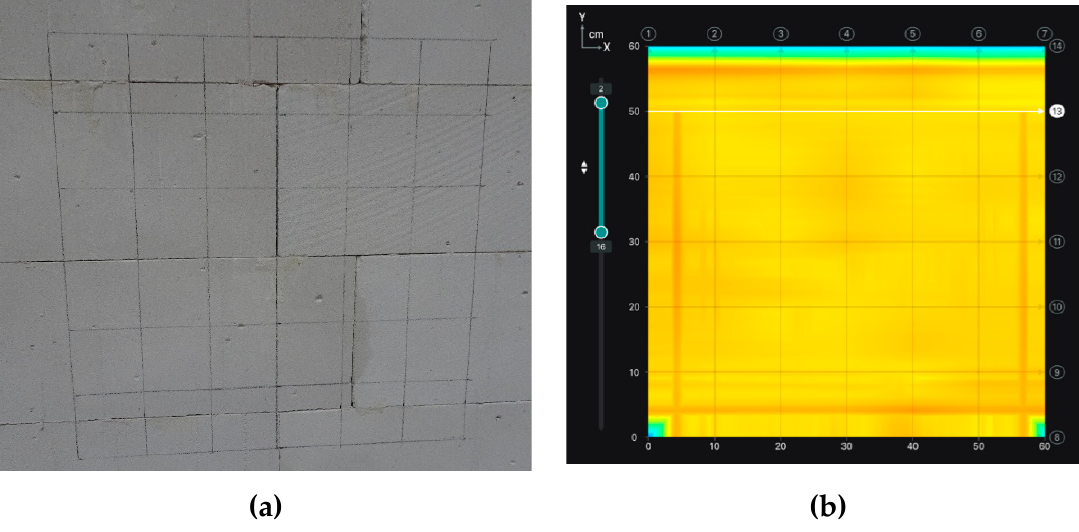
Figure 6. Tests on unreinforced masonry wall: ( a ) photo of tested area, ( b ) results from tests with Ground-Penetrating Radar (GPR) equipment (C-scan)-no visible